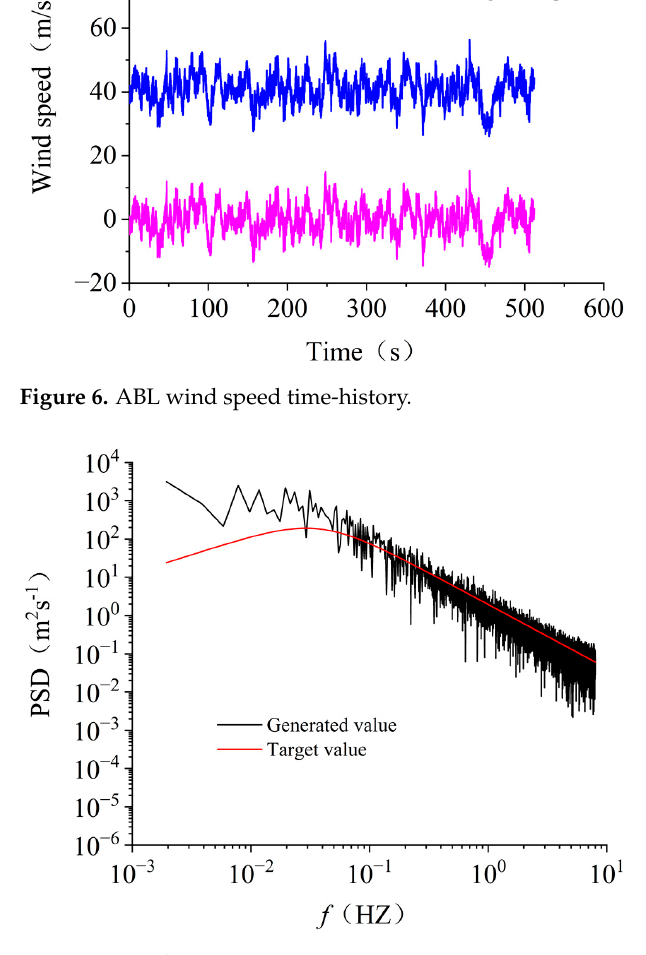
Figure 7. Wind spectrum comparison.